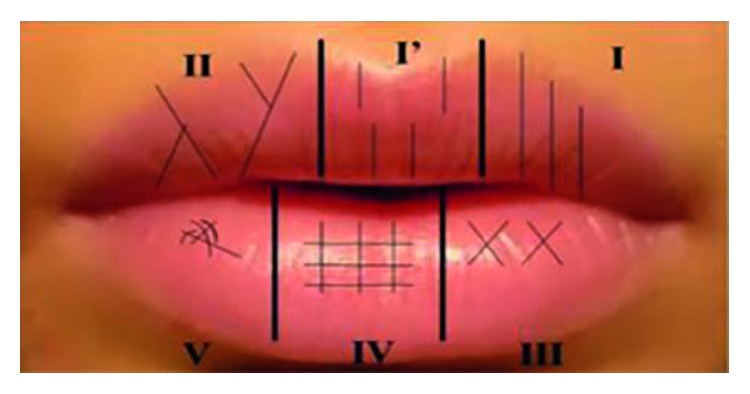
Classification by Suzuki and Tsuchihashi [12].